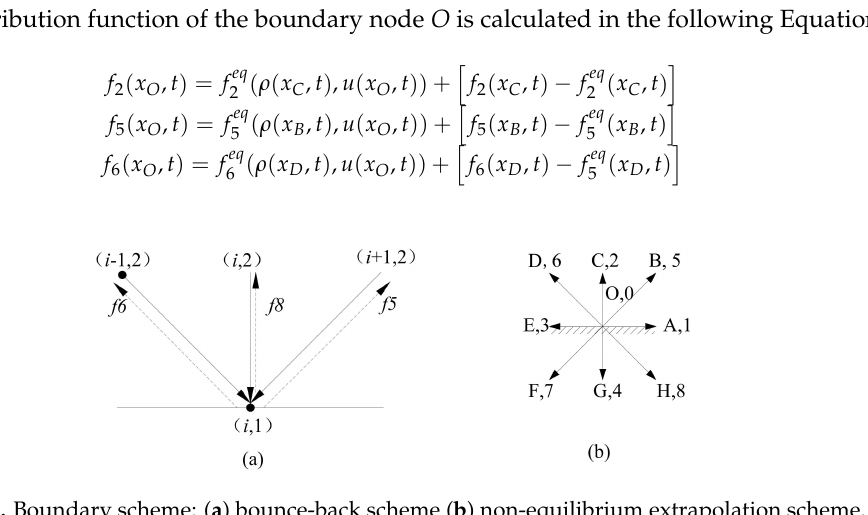
Figure 1. Boundary scheme: ( a ) bounce-back scheme ( b ) non-equilibrium extrapolation scheme.